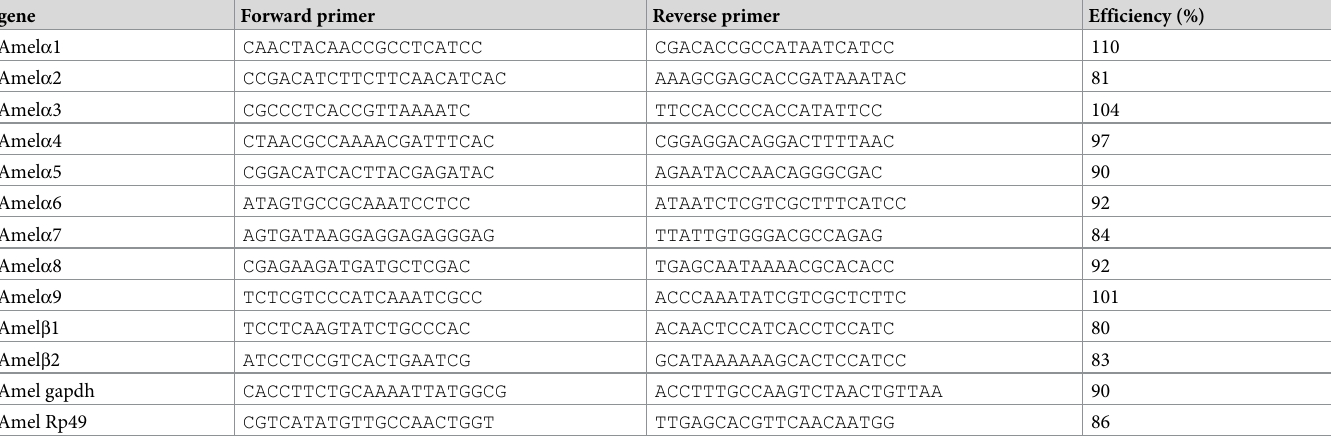
Gapdh = Glyceraldehyde 3-phosphate dehydrogenase; rp49 = Ribosomal protein